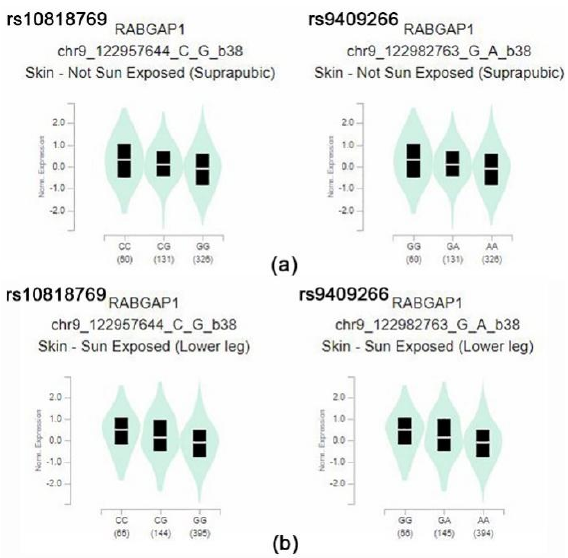
Figure 2. ( a ) Box plot of eQTL variant results ( p = 3.4 × 10 − 12 , p = 3.4 × 10 − 12 , respectively): rs10818769-skin (suprapubic), rs9409266-skin (suprapubic) ( b ) box plot of eQTL variant results ( p = 6.4 × 10 − 12 , p = 6.0 × 10 − 12 , respectively): rs10818769-skin (lower leg), rs9409266-skin (lower leg) These variants showed significantly different expression eQTL in their minor allele of the RABGAP1 . Normalized expression (norm expression) was calculated in Transcript Per Million (TPM) units.